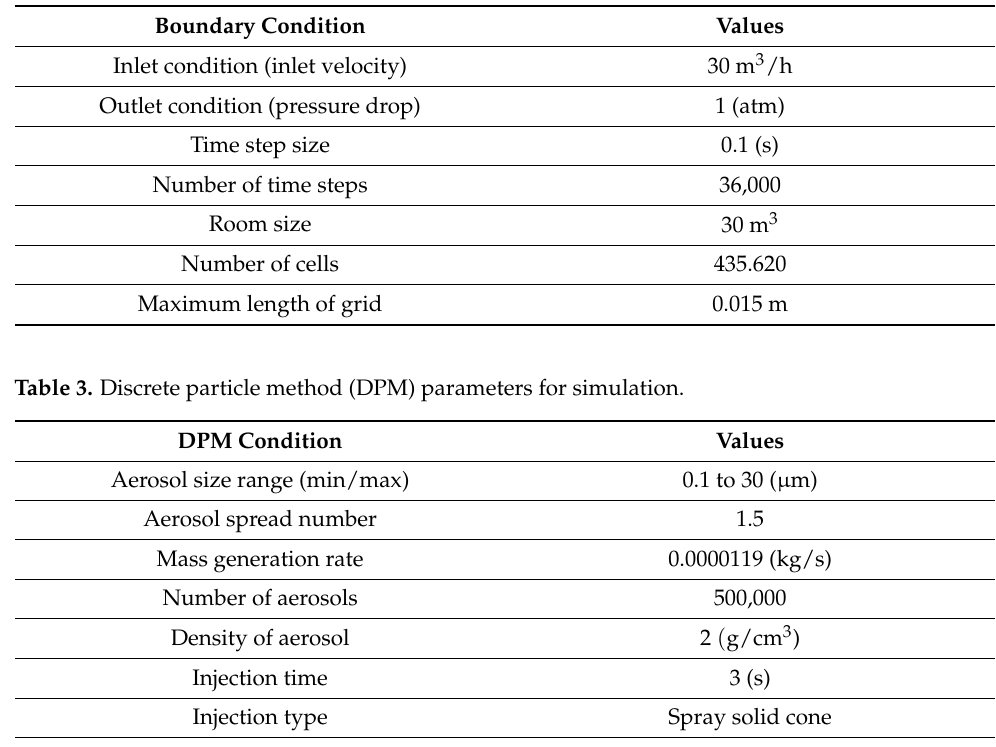
Figure 6. The measurement position, boundary condition and computation mesh domain of the chamber. The computational domain is divided into near field (green) and far field for validating the zero-dimensional spray model. Table 2. CFD parameters for simulation.